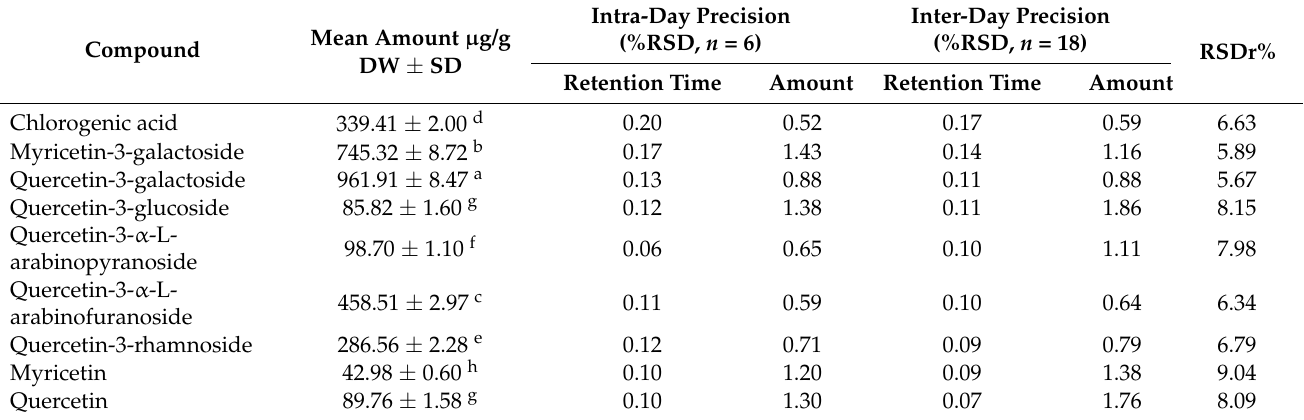
Table 4. Values of the precision parameters of the UPLC-DAD